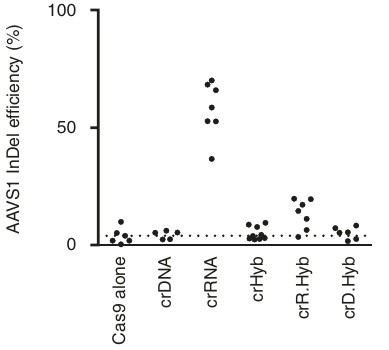
Fig. 5 RNA-rich hybrid crXNA molecules can direct speci fi c Cas9:tracrRNA nuclease activity in cells. Quanti fi cation of insertion and deletion (InDel) events at the AAVS1 locus 5 days after electroporation of Cas9:tracrHyb.v2: crXNA complexes. Dotted line show threshold determined from crDNA